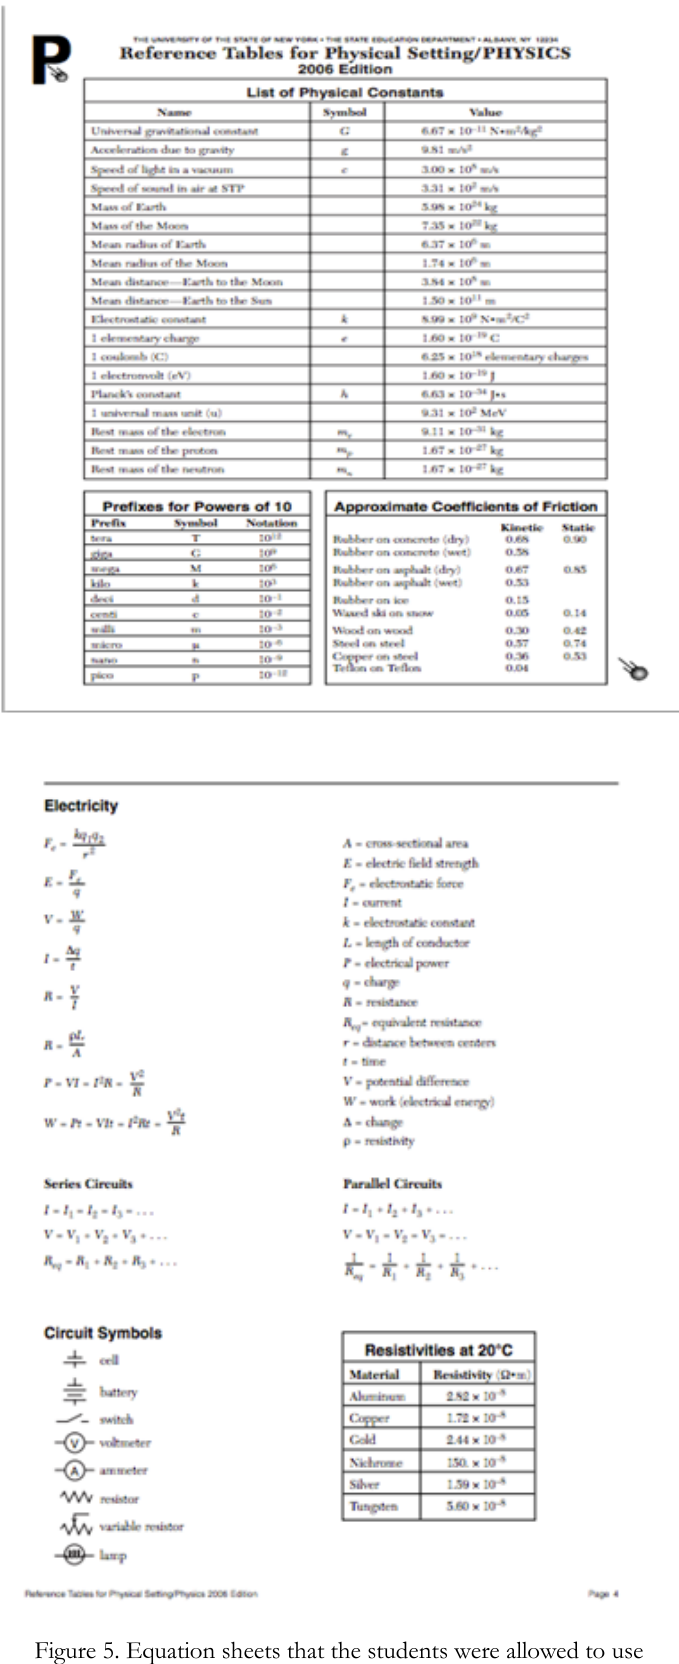
Figure 5. Equation sheets that the students were allowed to